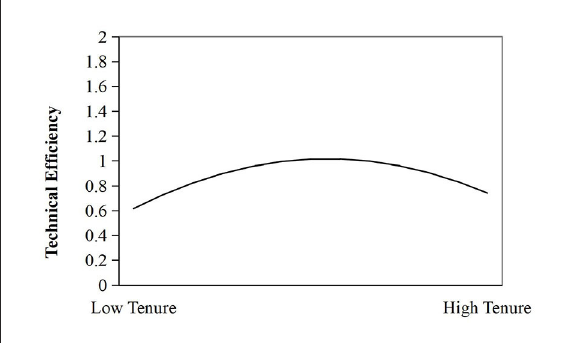
FIGURE2 The inverted U-shaped curve between Tenure and